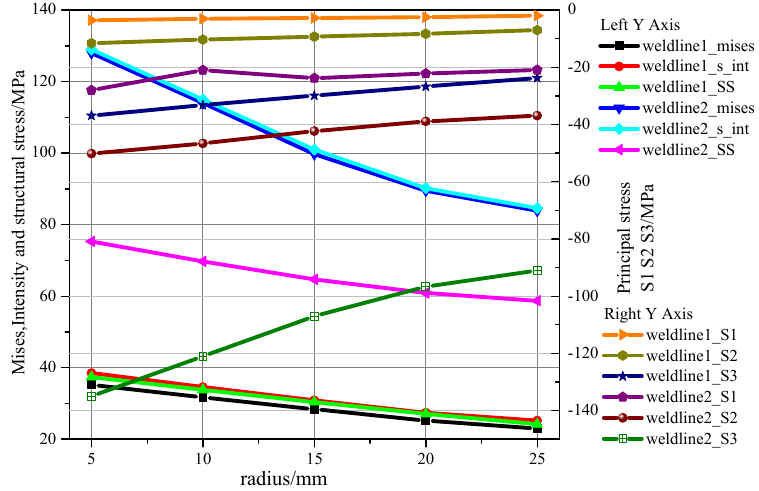
Figure 22. Trends of various stresses with the radius of the weld seam.